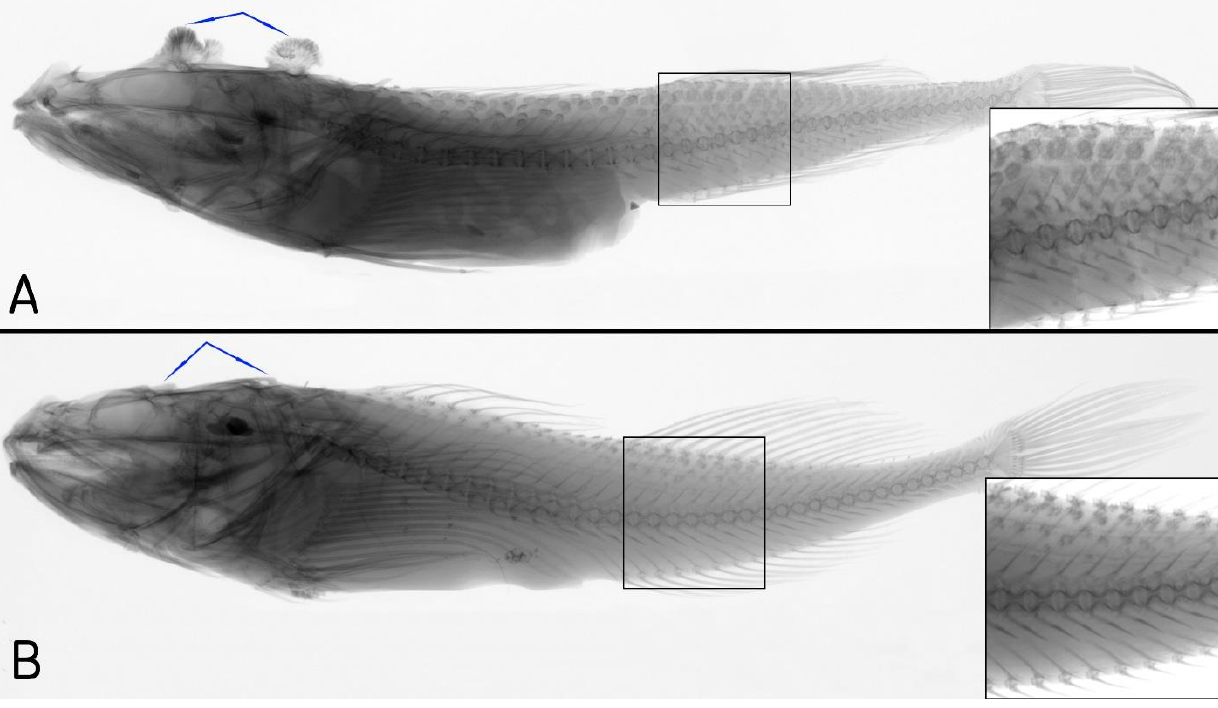
Figure 3. The axial skeleton: ( A ) T. quadricornis , NRM 2491; ( B ) Triglopsis sp., ZIN 56884. Arrows indicate the bony outgrowths; insets show enlarged bone plates.